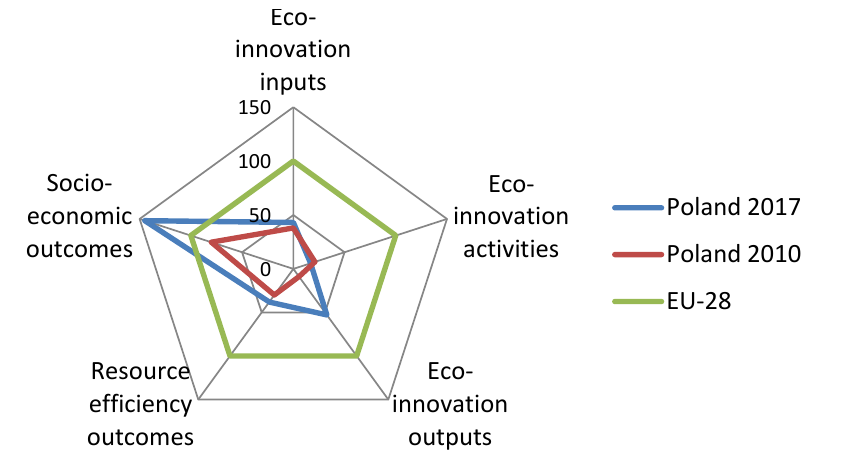
Fig. 2: Components of the Eco-Innovation Scoreboard index for Poland in 2010 and 2017